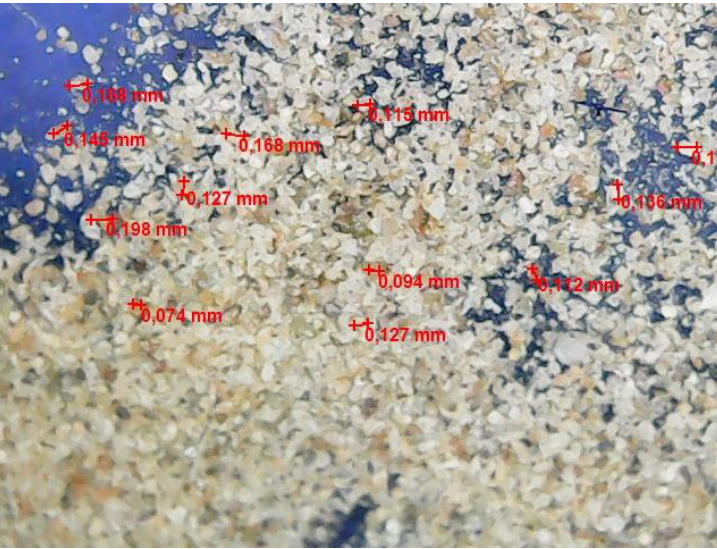
Figure 3. Freshly milled sand sample.